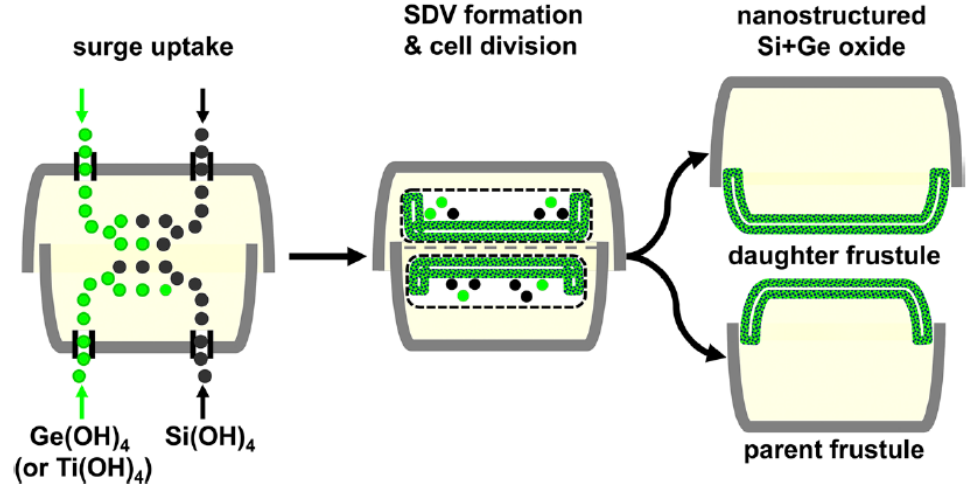
Figure 3. Alleged scheme of metabolic insertion of Ge or Ti into the diatom frustule during cultivation.